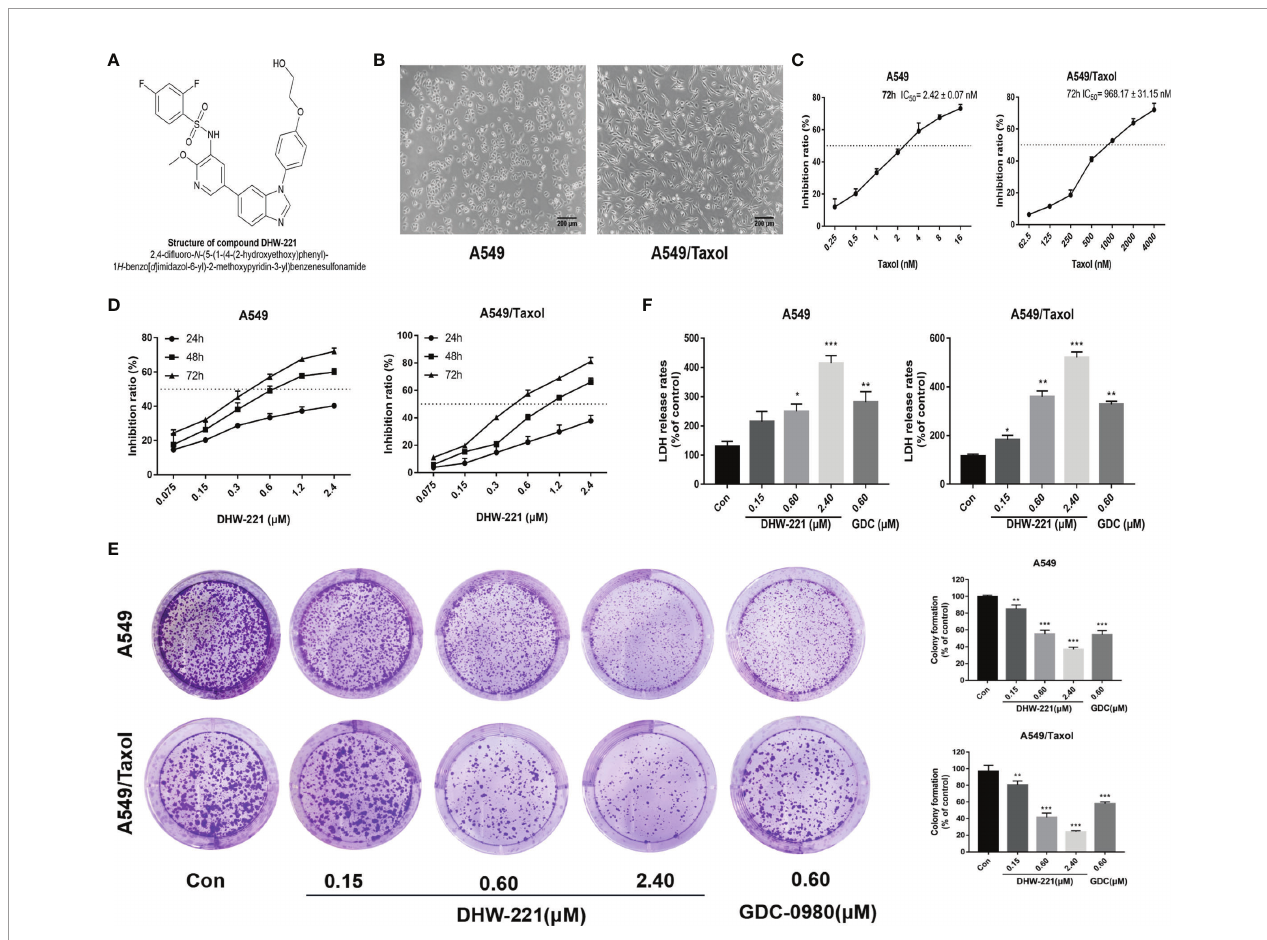
FIGURE 1 | DHW-221 inhibits cell viability in A549 and A549/Taxol cells. (A) The chemical structure of DHW-221h. (B) Representative morphology of parental and Taxol-resistant NSCLC cells (A549 and A549/Taxol cells). Scale bar = 200 m m. (C) Inhibition effect of A549 and A549/Taxol cells after exposure to Taxol for 72 h. (D) Cell viability of A549 and A549/Taxol cells treated with various concentrations of DHW-221 for 24,48, and 72 h. (E) The growth-inhibitory effect of DHW-221 on A549 and A549/Taxol cells was measured by colony formation assay; the quantitative results were illustrated as the right panel. (F) Cytotoxicity of DHW-221 was examined by LDH release assay for 48 h. Statistical comparisons were performed with one-way ANOVA followed by Dunnett ’ s post-hoc test for multiple comparisons (n = 3). Data were expressed as mean ± SD. *p < 0.05, **p < 0.01, ***p < 0.001 versus